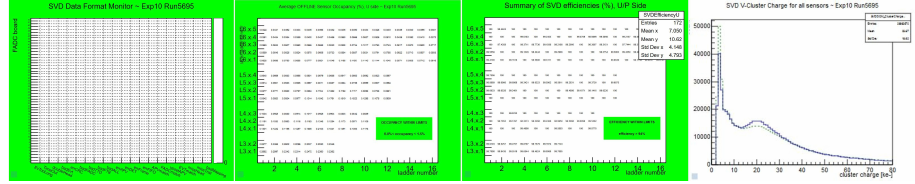
Figure 7. Basic SVD diagnostic plots avilable for Control Room shifters, left to right: Chip monitor (APV25-to-FADC-to-sensor mapping and status); Occupancy in U strips; E ffi ciency; Cluster charge in V